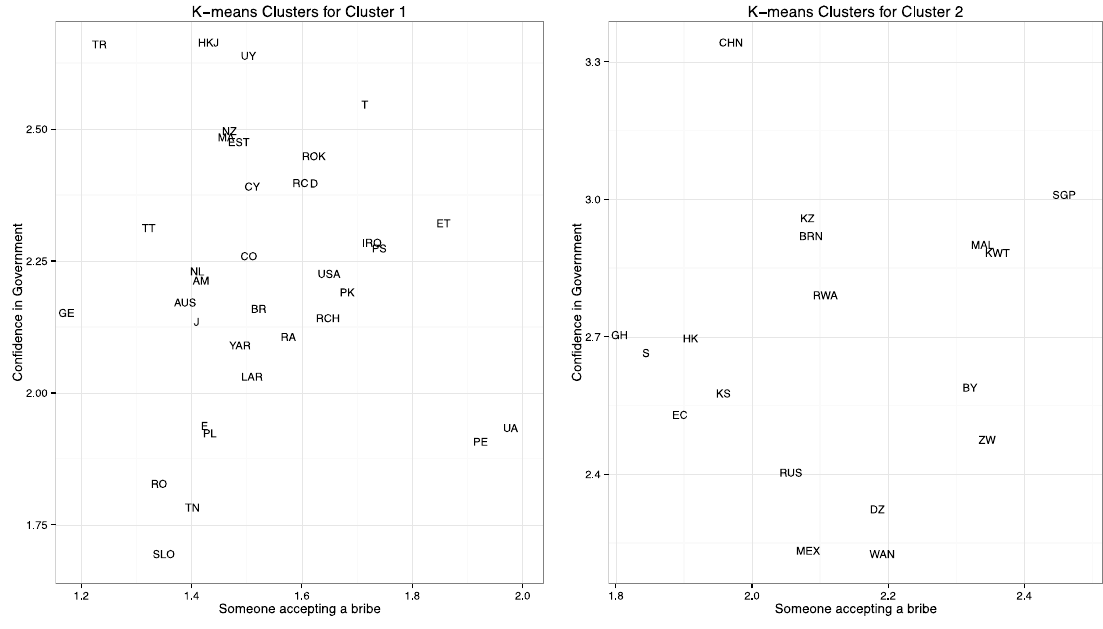
Figure 3. Number of clusters chosen by 26 criteria.